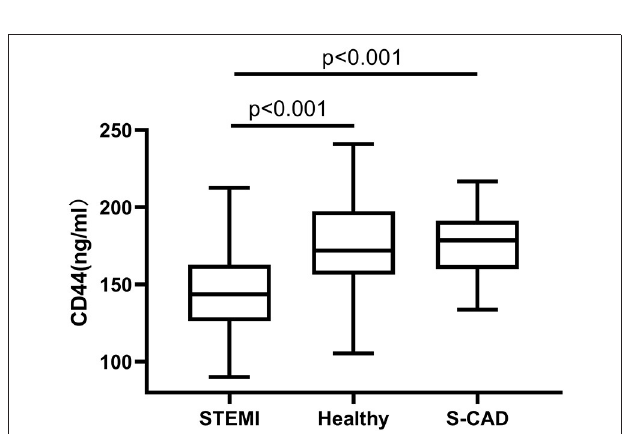
FIGURE 5 | Relations of plasma CD44 levels among patients with STEMI, S-CAD and healthy subjects. HA, hyaluronan; STEMI, ST-Segment–Elevation Myocardial Infarction; S-CAD, Stable Coronary Artery Disease.